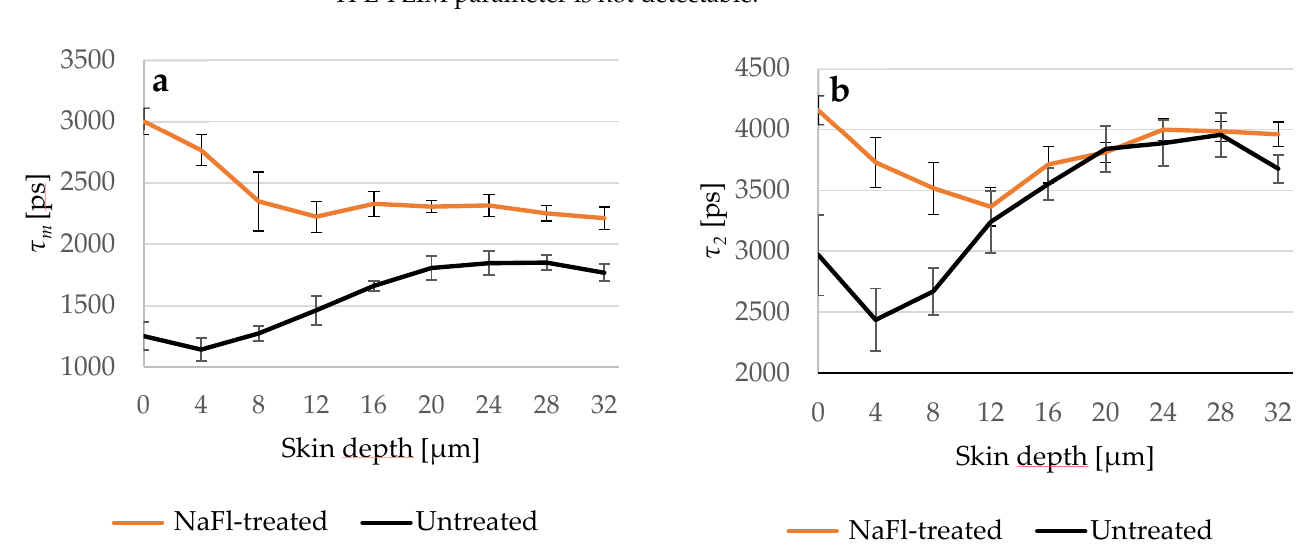
Figure 4. ( a ) Comparison between τ m of the untreated (black line) and NaFl -treated (orange line) skin depending on the depth; ( b ) τ 2 of both skin samples in different depths. τ 2 curves overlapped at 12 µ m, while τ m of the NaFl -treated skin was longer at all measured depths. SC thickness is 16.0 ± 3.3 µ m. N = 6.